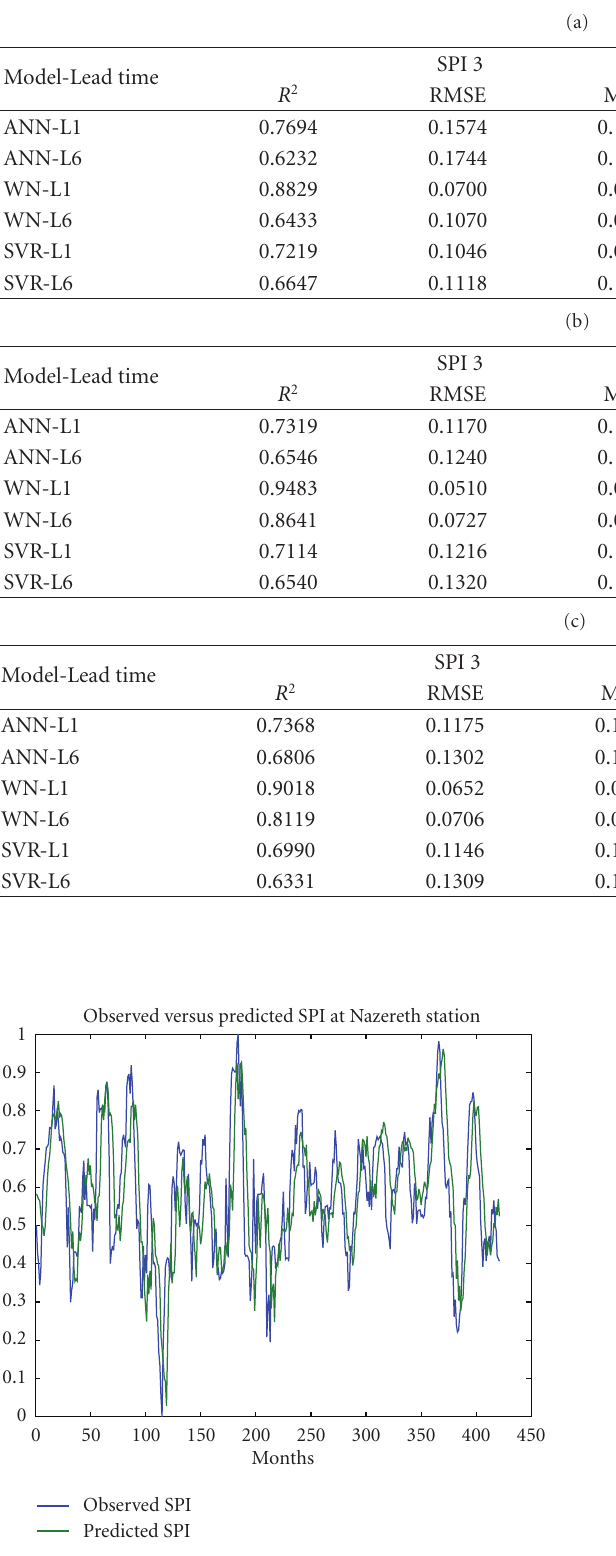
Table 3: (a) Performance results for the Ejersalele station, Upper Awash Basin, (b) Performance results of Nazereth Station, Middle Awash Basin, (c) Performance results of Dubti Station, Lower Awash Basin.